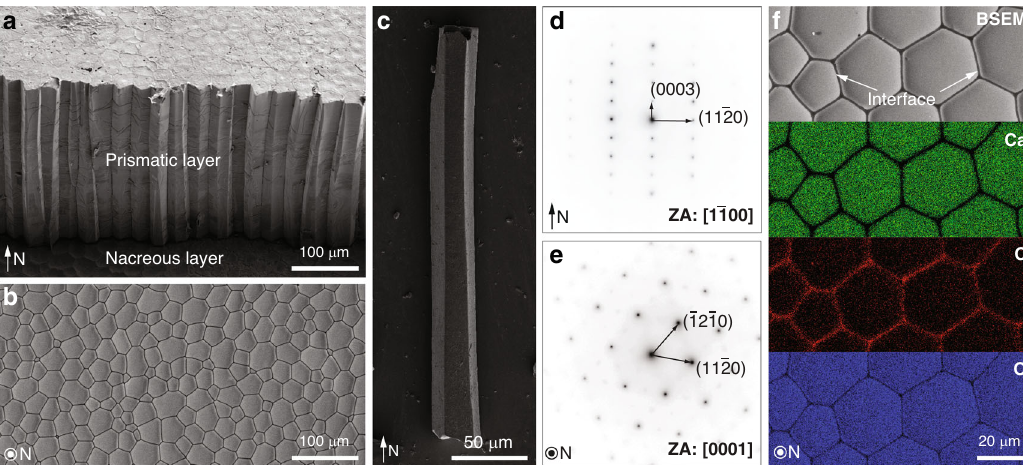
Fig. 1 Biogenic calcite in the prismatic layer of the mollusk Atrina rigida . a Scanning electron micrograph (SEM) of the shell cross-section showing the prismatic layer (upper region) and the nacreous layer (lower region) in the shell. The normal direction of the shell is indicated by the arrow ( “ N ” ). b Backscattered SEM (BSEM) image of the prismatic layer sectioned and polished in the direction perpendicular to “ N ” , which shows the polygonal cross sections of the prismatic crystals. c SEM image of one isolated prismatic crystal. d , e Selected area electron diffraction (SAED) patterns taken from two sections prepared from two orientations, d parallel to the normal direction (zone axis (ZA): [1 (cid:1) 100]) and e perpendicular to the normal direction (ZA: [0001]). f Energy dispersive spectroscopy (EDS) elemental mapping of the calcitic prisms and their intercrystalline organic interfaces. From top to the bottom, BSEM image revealing the local differences in electron density, and their corresponding Calcium, Carbon, and Oxygen